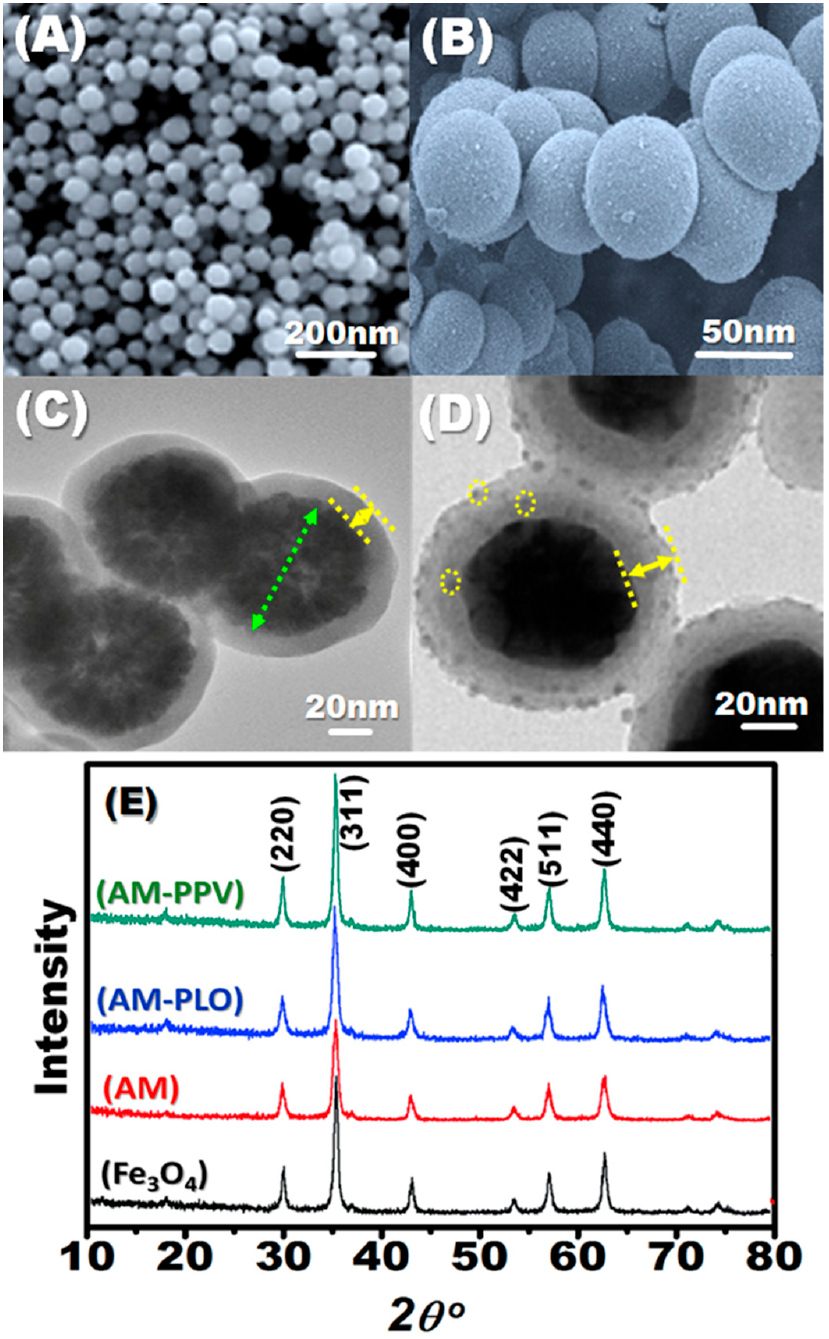
Figure 1. Field-emission scanning electron microscopy (FE-SEM) images with low ( A ) and high ( B ) magnifications of amino magnetic nanospheres (AM-NSs). High-magnification STEM images of AM-NSs ( C ) and AM coated with PLO/PEG/VCM (AM-PPV) NSs ( D ). ( E ) WA-XRD spectra of magnetic NSs (Fe 3 O 4 ), AM-NSs, AM-PLO, and AM-PPV NSs.